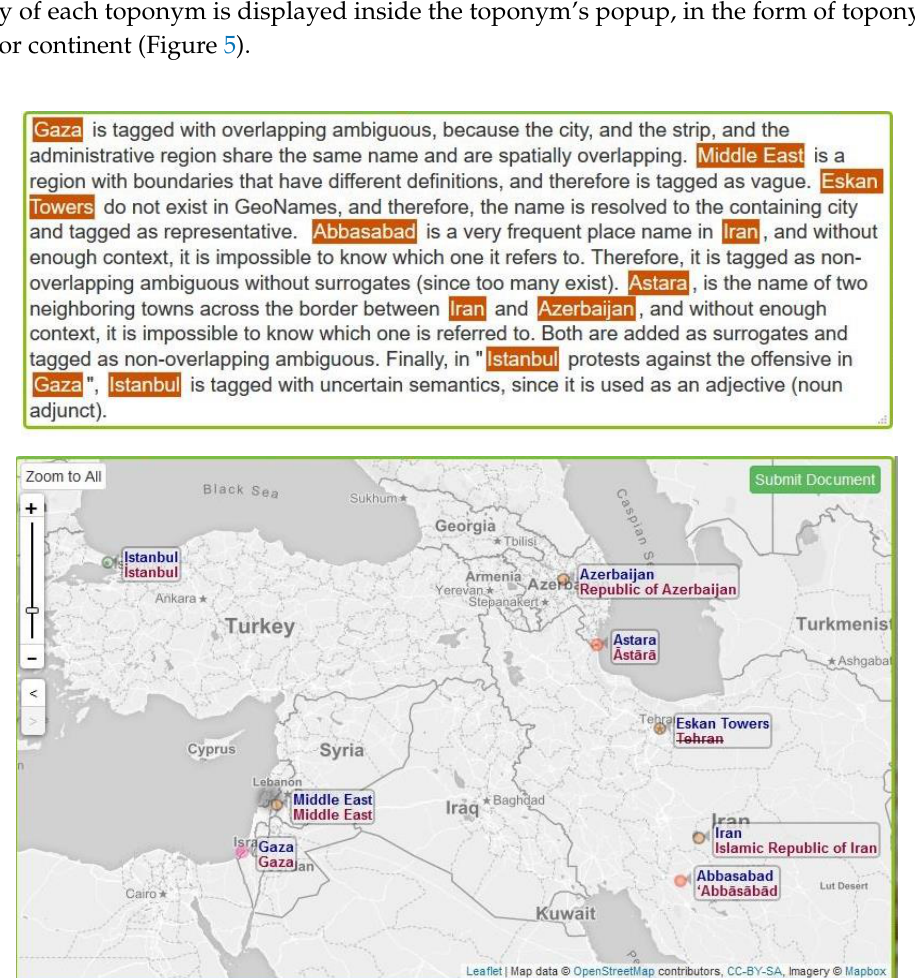
Figure 5. Disjoint map symbols for special tags.